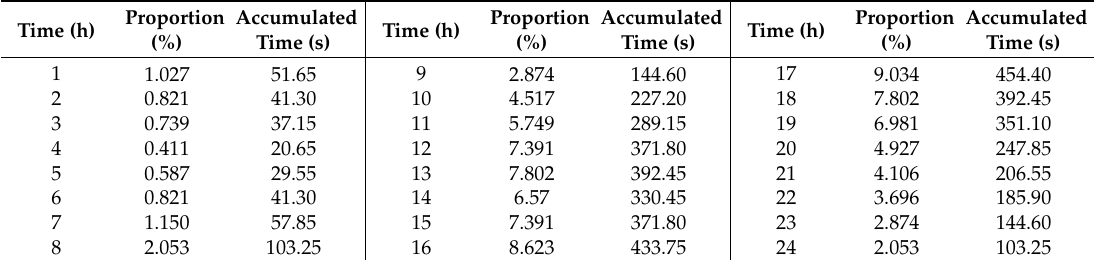
Table 13. Accumulated axial load time of at different time periods.